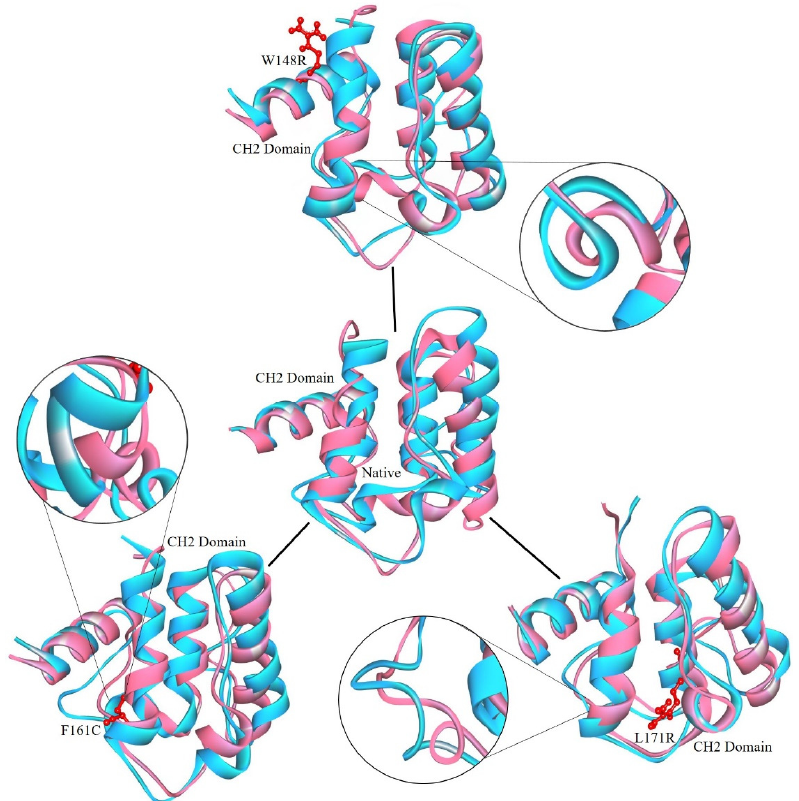
Figure 7. Conformational local shifts of the CH2 domain from the native and mutant FLNB protein’s MD trajectory. The secondary structure of 0ns (magenta) and the secondary structure of 100 ns (cyan) are depicted. The mutation sites are marked in red (ball and stick model), whereas the magnified circles represent the local changes in the CH2 domain due to